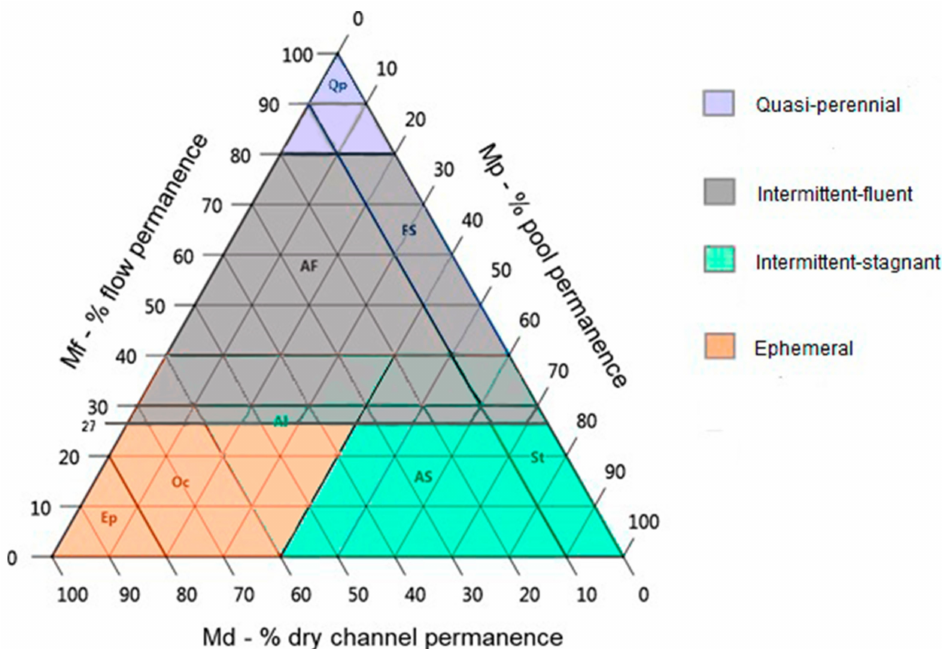
Figure 7. Four “management temporary river categories” (MTRCs): perennial and quasi-perennial, intermittent-fluent, intermittent-stagnant, and ephemeral, proposed for the Mediterranean Spanish basins [54], according to the three main axis (aquatic phases): flow permanence (Mf), disconnected pools permanence (Mp), and dry river permanence (Md) provided by TREHS